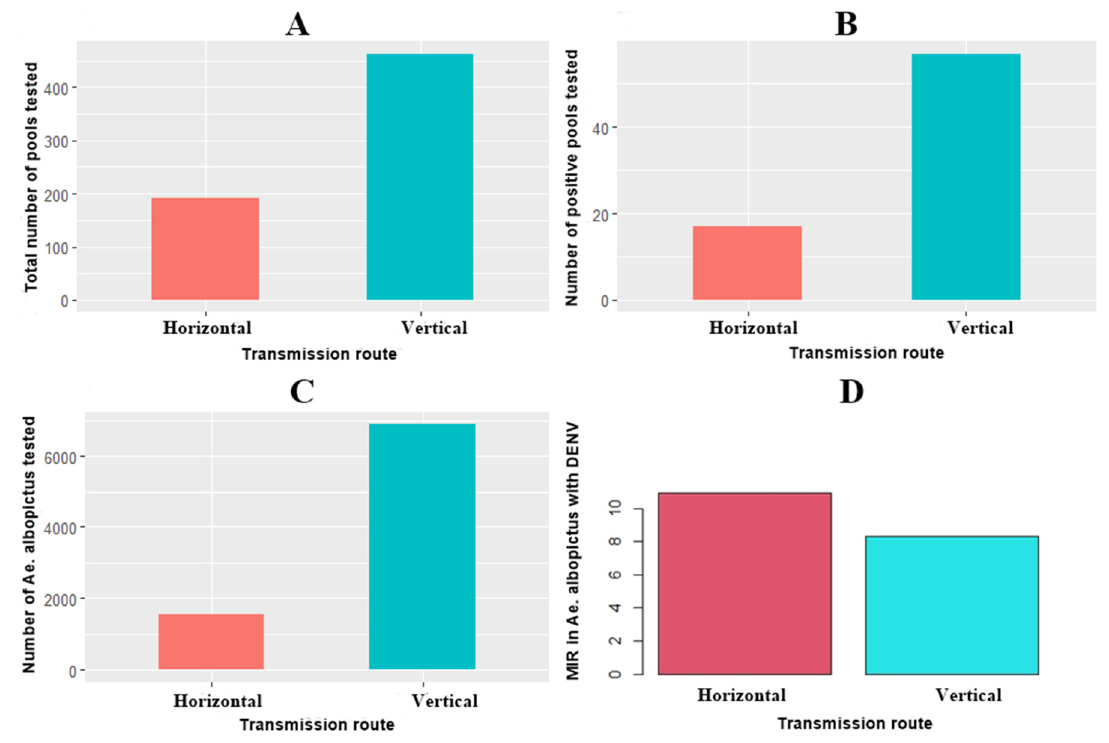
Figure 1. Aedes albopictus infected with DENV. ( A ) Total number of pools tested, ( B ) Number of positive pools tested, ( C ) Number of Ae. albopictus tested, and ( D ) MIR.